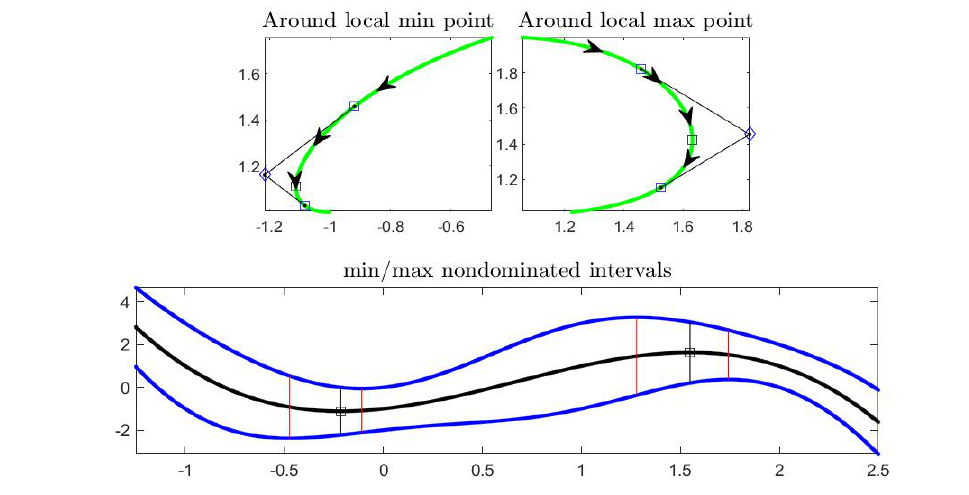
Figure 2. Efficient frontiers for min and max points of F ( x ) in Example 1. The top pictures show the efficient frontier for x m (left) and for x M (right) with the tangent lines to the curve F . In the bottom picture , the efficient frontiers are delimited by vertical red segments containing the min and the max points.